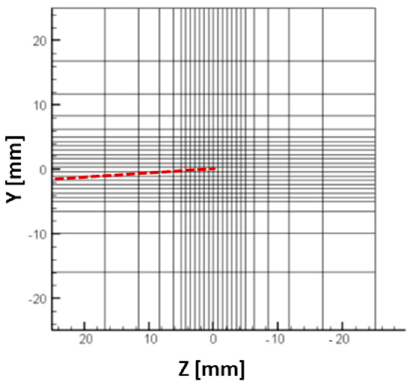
Figure 6. High resolution grid for the 3rd measurement plane (regular wingtip). The trailing edge is marked with dark